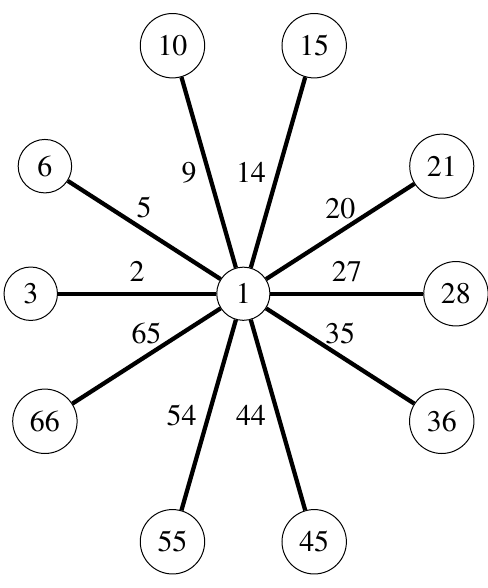
Fig.1. Range Labelling for star tree S